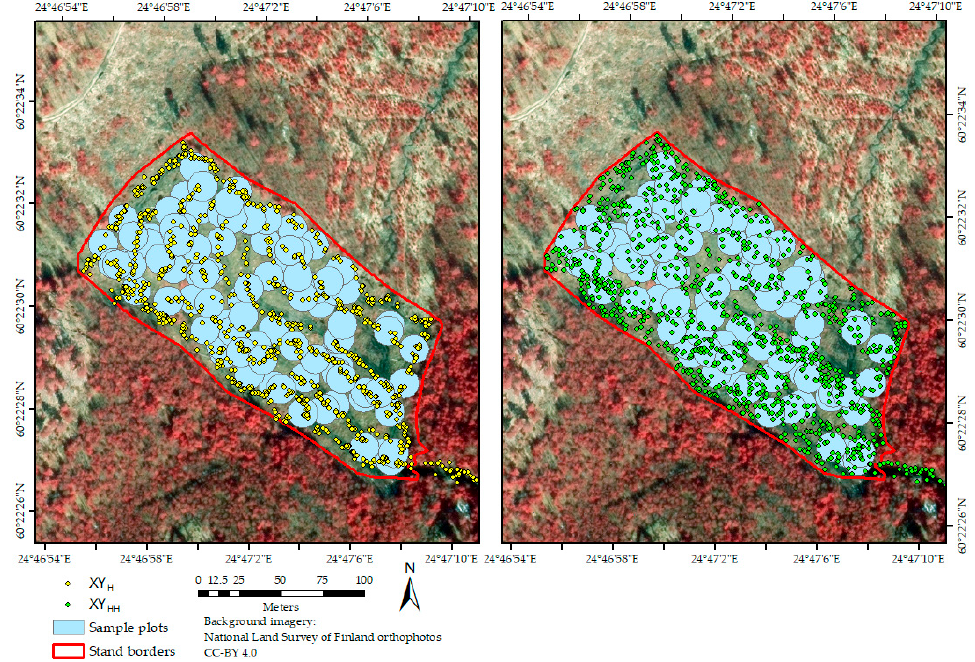
Figure 2. One of the modeling stands in the study area, showing 100 generated sample plots (r = 9 m). Left: the location of each tree is determined based on the harvester’s GNSS position (XY H ). Right: the location of each tree is based on the computationally derived harvester head position (XY HH